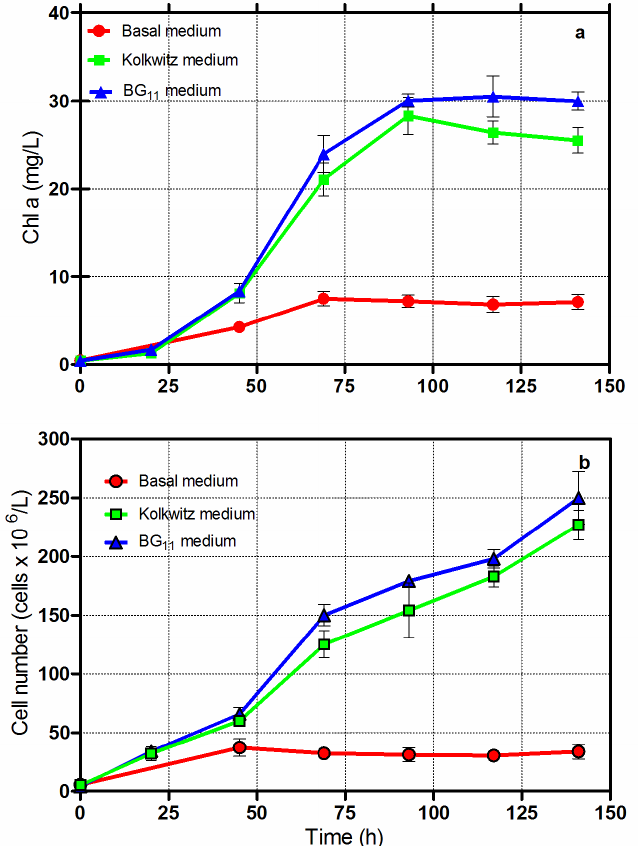
Figure 1. Batch growth of Chlorella vulgaris CCALA 896 using three different synthetic culture broths: Basal; Kolkwitz and BG-11. All experiments were carried out at 30 °C, and with a light intensity of 150 µE/m 2 /s.